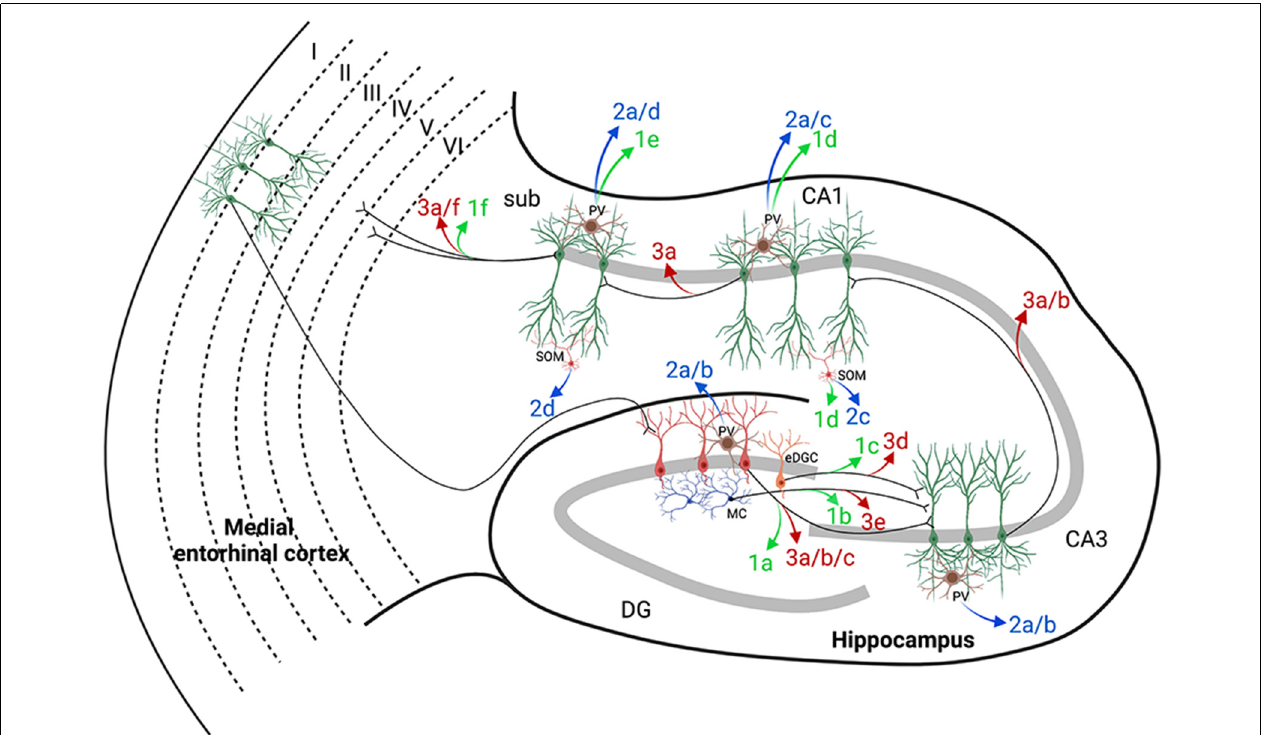
FIGURE 3 | Hippocampal targets of chemogenetics interrogated by each of the authors cited. The two classically defined inputs from the entorhinal cortex (EC) to the hippocampus are the perforant pathway (PP; EC to DG) and the temporoammonic pathway (EC to CA1). A long excitatory synaptic loop (EC to DG to CA3 to CA1 to subiculum and EC) receives inputs from the PP by innervation of the dentate gyrus (DG) and is known as the trisynaptic pathway. Table 1 provides a key to the denoted projections and is organized by where each of the authors are cited in this review. Projections denoted in green were used by the authors cited to either potentiate or induce seizures with DREADDs (figure reference designation of 4). Blue labels indicate where hM3Dq was used to decrease seizures (figure reference designation of 5). Red labels indicate where hM4Di was used to decrease seizures (figure reference designation of 6). Projections labeled in black indicate connectivity that may contribute to the circuits evaluated. Created in BioRender.com. CA, Cornu Ammonis; DG, dentate gyrus; DREADDs, designer receptors exclusively activated by designer drugs; EC, entorhinal cortex; eDGC, ectopic dentate granule cells; hM3Dq, G q -coupled human M3 muscarinic DREADD; hM4Di, G i -coupled human M4 muscarinic DREADD; MC, mossy cells; PV, parvalbumin interneurons; SOM, somatostatin interneurons; Sub,